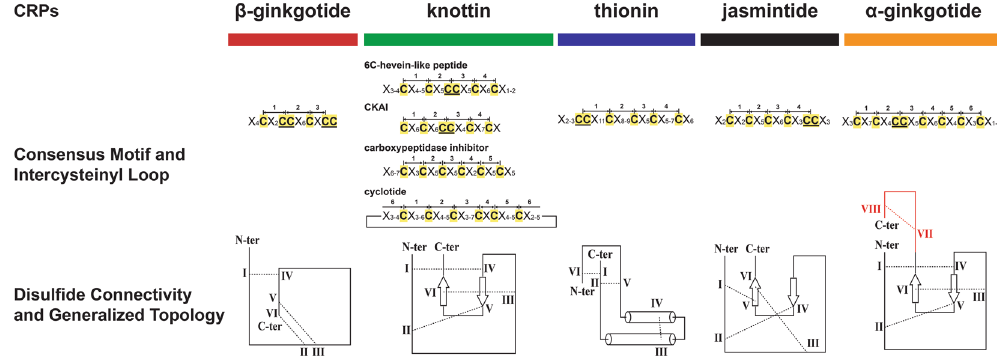
Figure 5. Cysteine framework comparison of plant CRPs with six cysteine residues. β -Ginkgotide β -gB1 displayed a novel cysteine spacing of C–CC–C–CC, with the presence of two CC motif forming three intercysteinyl loops as compared to other CRPs consisting four to six intercystinyl loops. β -Ginkgotide β -gB1displayed a novel disulfide connectivity of CysI–CysIV, CysII–CysVI, CysIII–CysV, which differed from other known CRPs such as cystine knot peptides (CysI ‒ CysIV, CysII ‒ CysV and CysIII ‒ CysVI), thionins (CysI ‒ CysVI, CysII ‒ CysV and CysIV ‒ CysVI) and jasmintides (CysI ‒ CysV, CysII ‒ CysIV and CysIII ‒ CysVI). Intercysteinyl cysteine content refers to the percentage of cysteine present within the cystine core (between the first and last cysteine), in which β -ginkgotide β -gB1displayed the highest content among